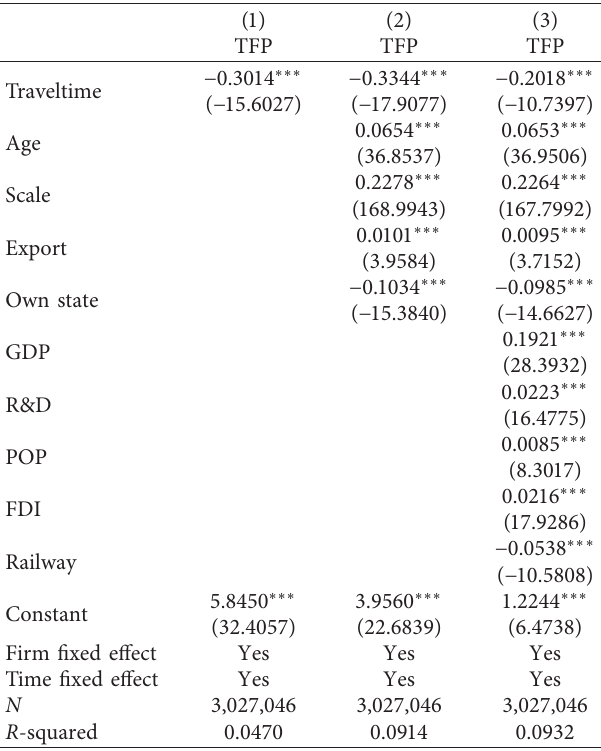
Figure 5: Highway travel time and firm productivity, 2000–2013. Table 5: Result of baseline regressions.